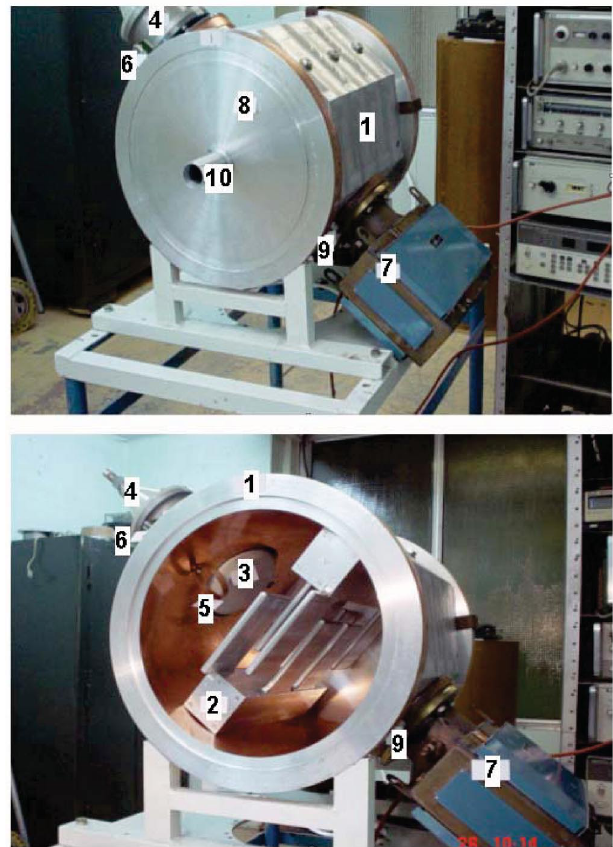
FIG. 14. (Color) The rf deflector test facility: 1—deflector con- tainer, 2—plate system, 3—ceramic window, 4—rf power unit, 5—copper ring, 6—unit of frequency tuning, 7—vacuum pump, 8—circular flange, 9—indicator loop, 10—beam pipe.